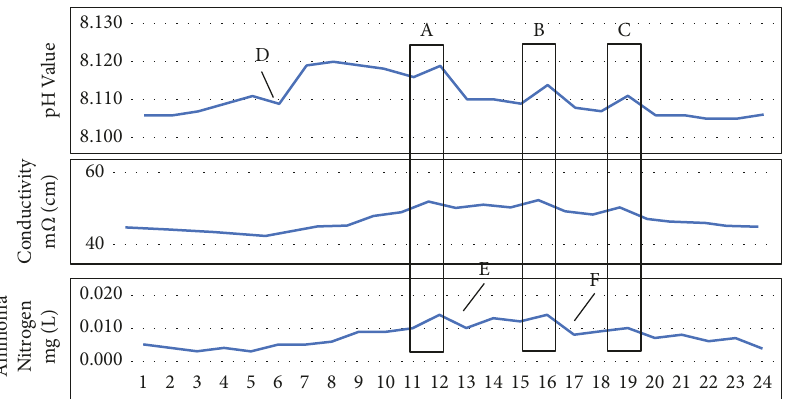
Figure 3: Coastal water quality anomaly detection.